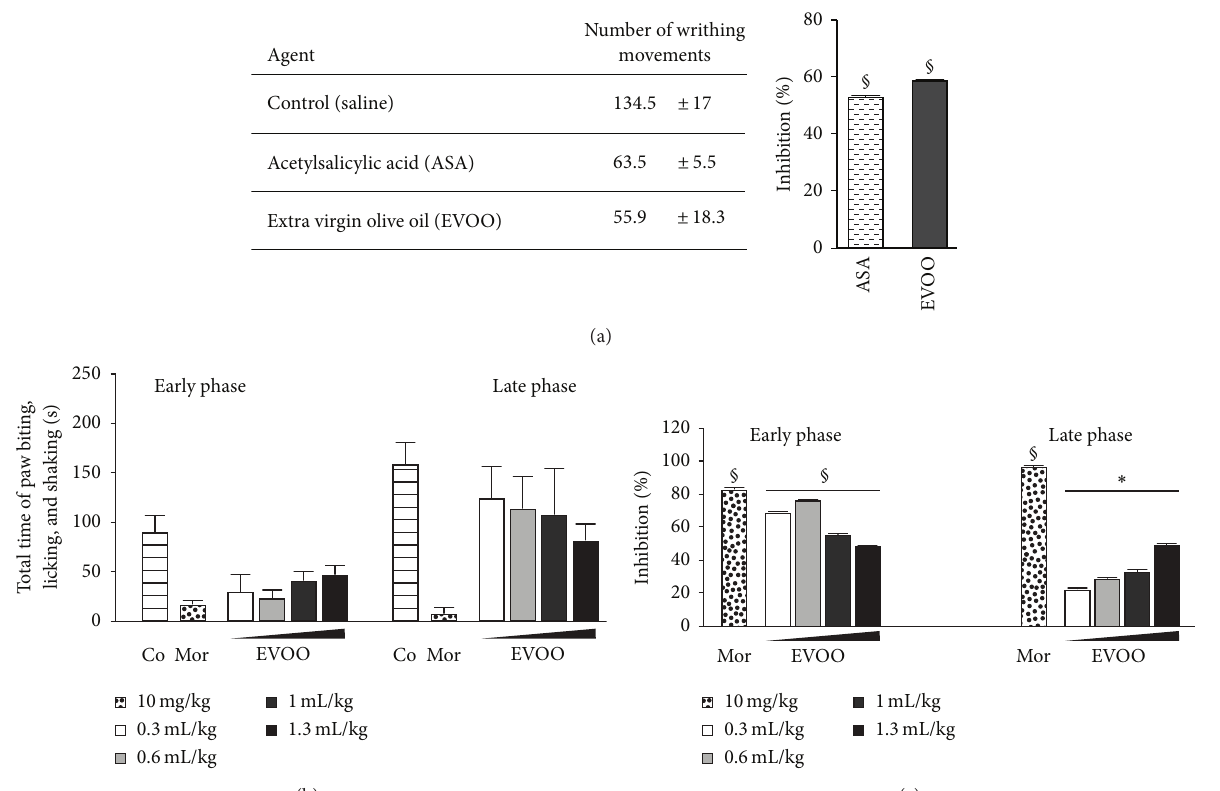
Figure 1: Antinociceptive effect of extra virgin olive oil. (a) Effect of intraperitoneal administration of acetylsalicylic acid (3.2g/kg) and extra virgin olive oil (8mL/kg) on acetic acid-induced Writhing. (b) Effect of intraplantar injection of morphine (10mg/kg) and extra virgin olive oil (resp. 0.33, 0.66, 1, and 1.33mL/kg) on formalin-Induced nociceptive behavior in mice at early and late phase. acetylsalicylic acid and morphine used as reference agents. (c) Percentage of formalin-induced nociceptive inhibition by extra virgin olive oil and reference agents as compared to saline-treated mice. Results are reported as means ± SD. ∗ 𝑃 < 0.05 and § 𝑃 < 0.001 (two-tailed Student’s 𝑡 -test), as compared to saline-treated